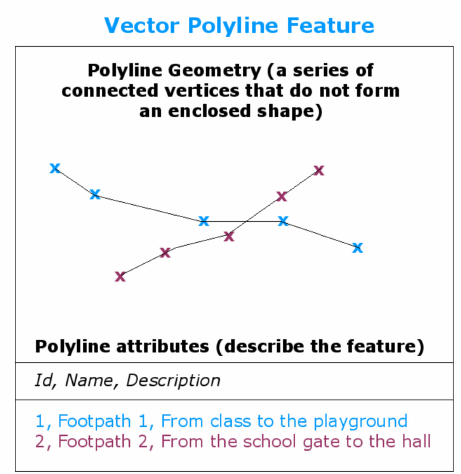
Figure 2. Linear type vector geometry.